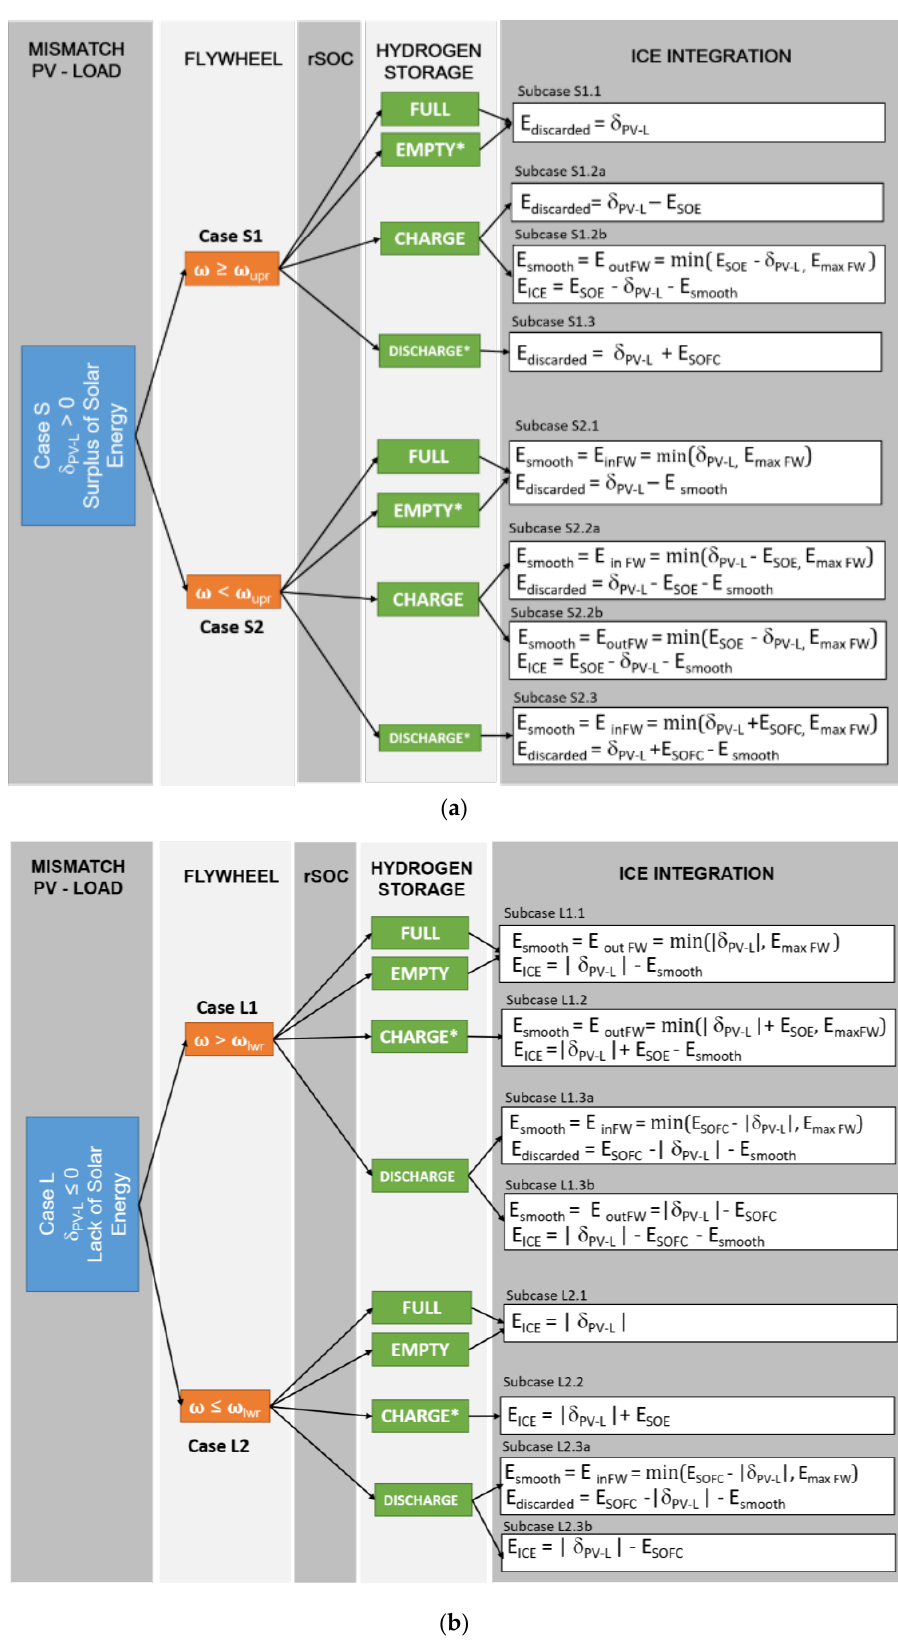
Figure 7. Management logic-tree: ( a ) Case S (RES Surplus), ( b ) Case L (Lack of RES).